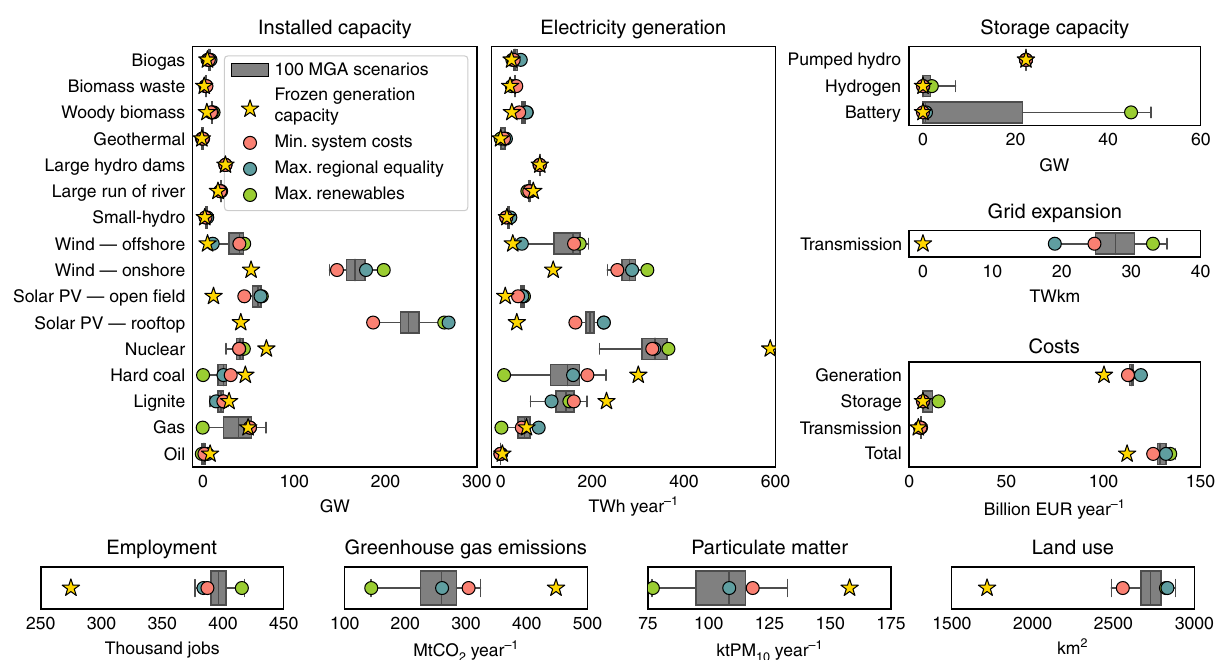
Fig. 1 Scenarios of electricity generation in 2035. The fi gure shows technology-speci fi c generation, storage, and transmission, as well as associated costs and regional impacts for the scenario of frozen generation capacity and the 100 modeling to generate alternatives (MGA) scenarios. Amongst the 100 MGA scenarios, we highlight the scenarios of minimum system costs, maximum regional equality of system costs, and maximum renewable electricity generation. Box plot elements are: center line, median; box limits, upper and lower quartiles; whiskers, minimum and maximum values. MGA scenarios